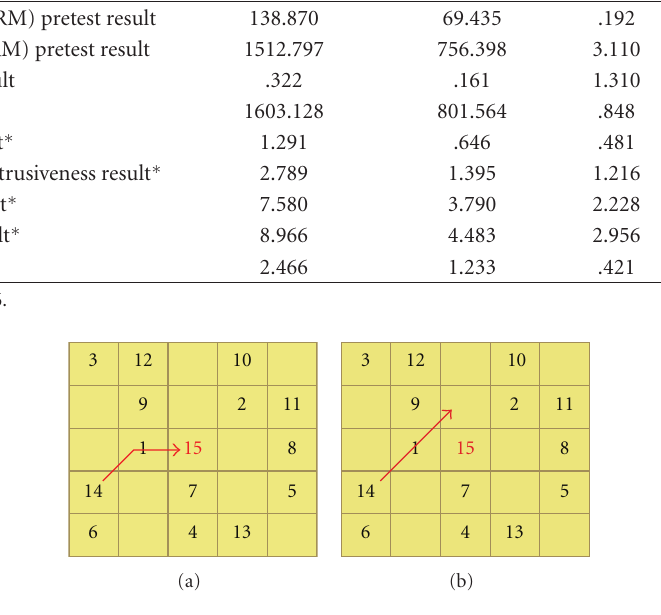
Figure 4: (a) Positive cue (answer) versus (b) negative cue (miscue).